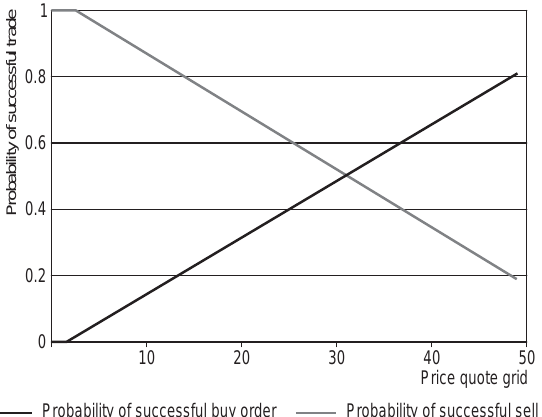
Fig. 2. Typical estimated demand and supply